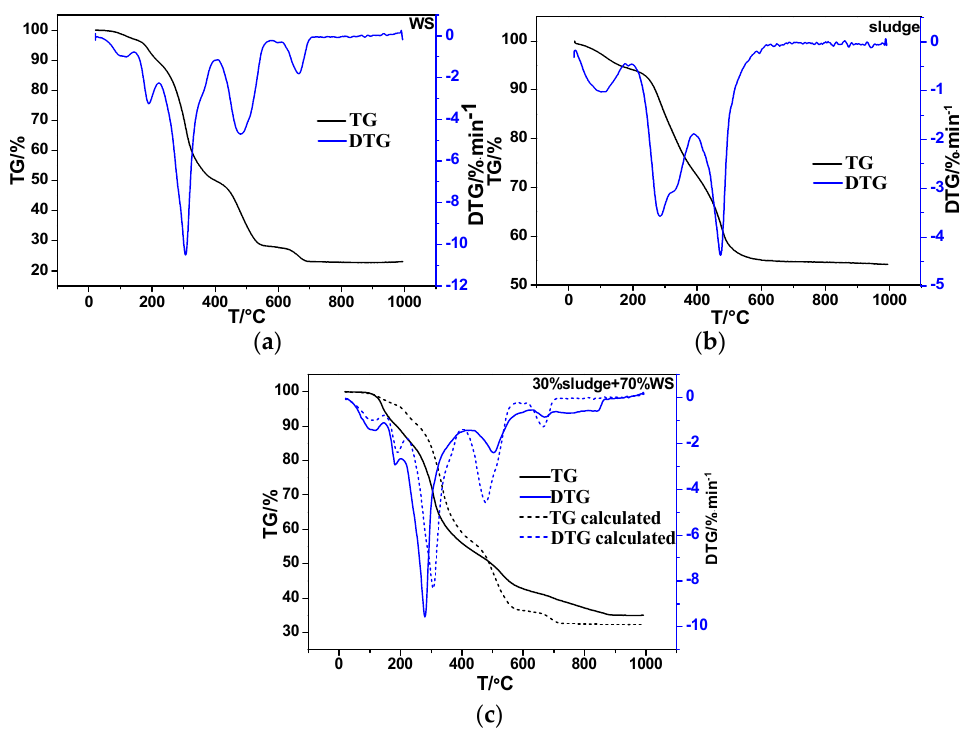
Figure 1. TG and DTG curves of: ( a ) wheat straw (WS); ( b ) sludge; ( c ) 70% WS + 30% sludge in air atmosphere.